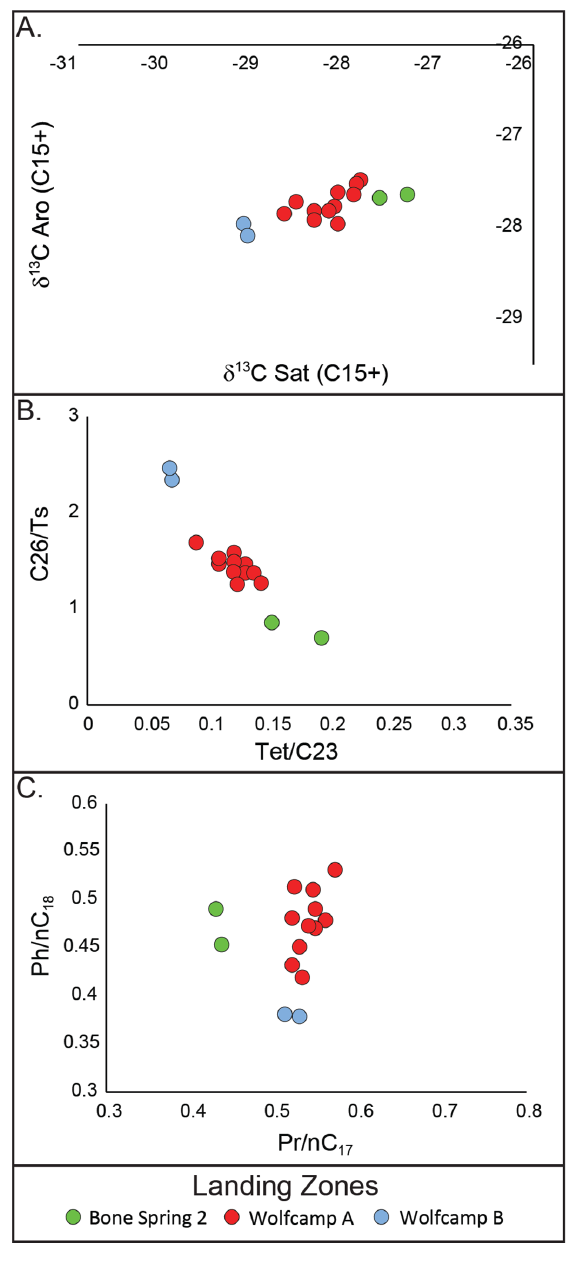
Figure 5. Bivariate Cross ‐ Plot Results of Baseline Produced Oil Samples from bulk, biomarker and gas chromatography results. ( A ) Carbon isotope signatures ( δ 13 C VPDB ) of the C15+ saturate and aromatic fractions. ( B ) Upwelling biomarker ratios C26 S&R tricyclic terpane/C27 pentacyclic terpane Ts (18 α ,21 β‐ 22,29,30 ‐ trisnorhopane) ratio (C26/Ts) relative to C24 tetracyclic terpane/C23 tricyclic terpane ratio (Tet/C23). ( C ) Cross ‐ plot of Pristane/nC 17 (Pr/nC 17 ) against Phytane/nC18 (Ph/nC 18 ).